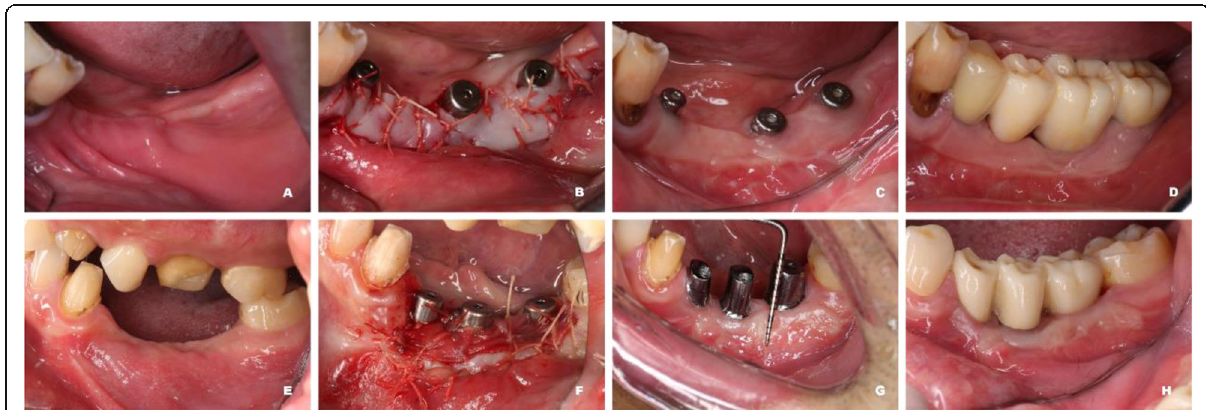
Fig. 5 Representative cases in both groups. a – d Representative case in FGG group, a before surgery, b immediately after surgery, c 3 months after surgery, d 6 months after surgery. e – h Representative case in XCM group, e before surgery, f immediately after surgery, g 3 months after surgery, h 6 months after